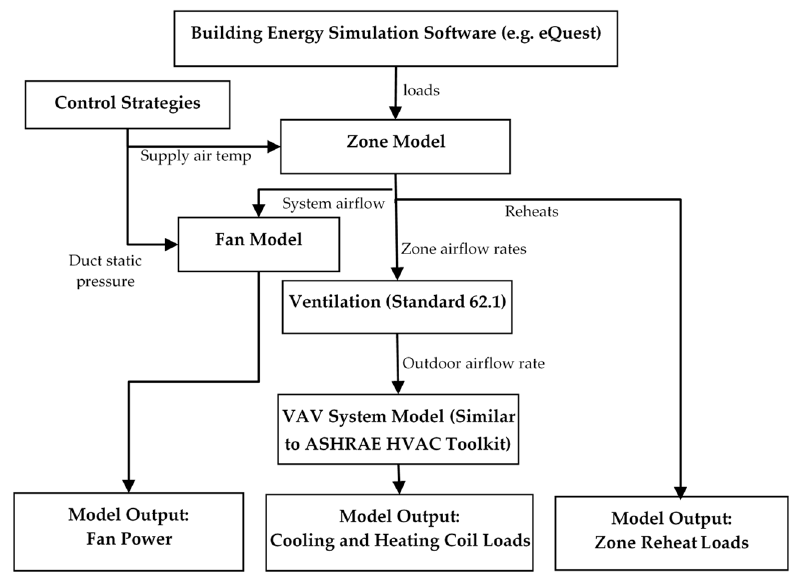
Figure 4. Modeling strategy used for single-duct and dual VAV systems.